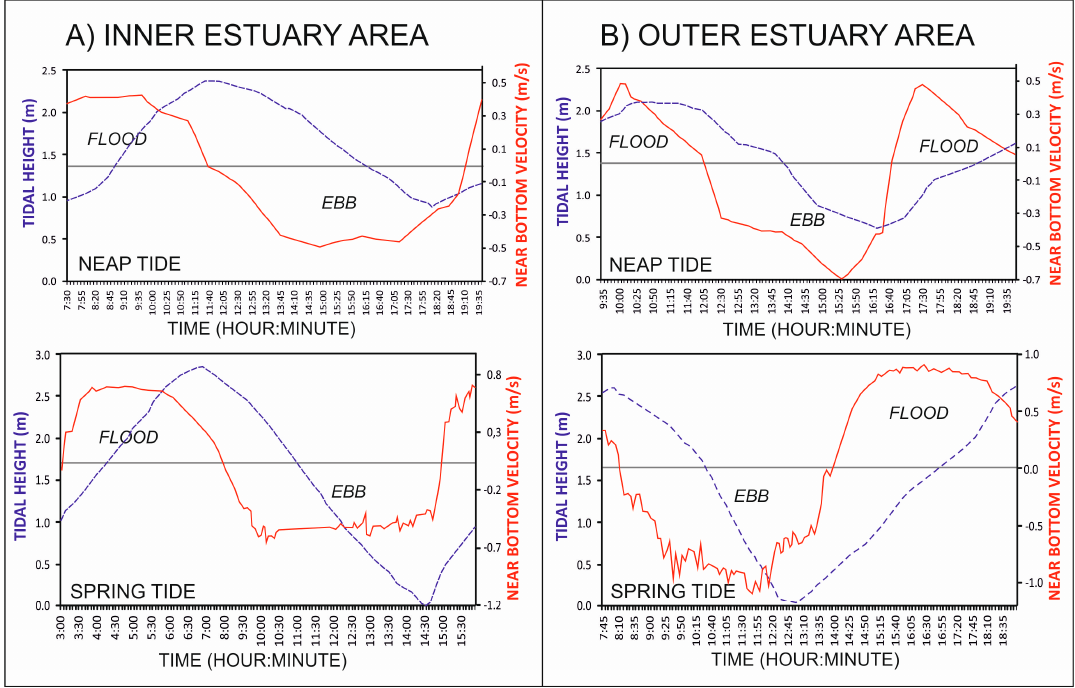
Figure 9. Curves of the water height and near-bottom currents over time in the fluvial estuary ( a ) and in the marine estuary ( b ). Measurements during the tidal cycles for the mean neap tide (upper) and mean spring tide (lower). The horizontal grey line refers to the value of 0 for the near-bottom velocity (right vertical axis).